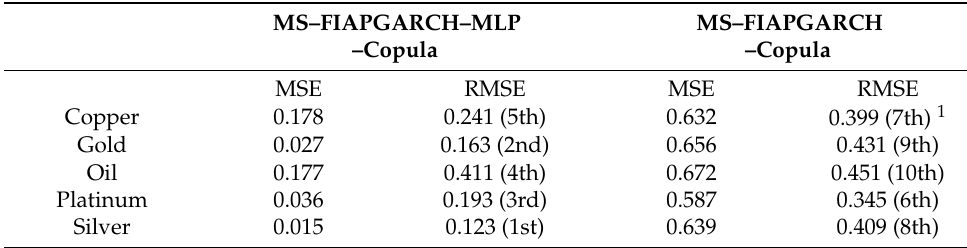
Table 8. Out of Sample Forecast